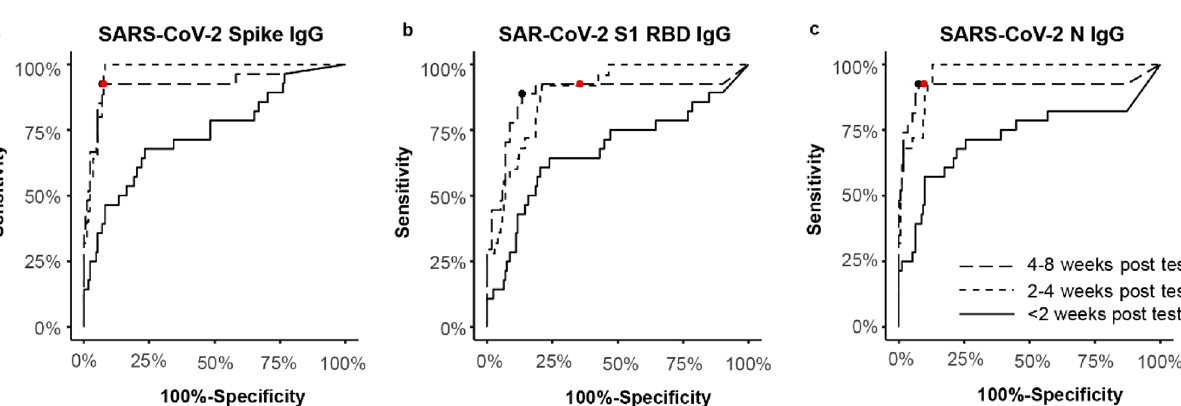
Figure 2. Correlation in IgG concentrations for SARS-CoV-2 antigens. Dotted lines indicate thresholds for classifying high versus low reactivity.